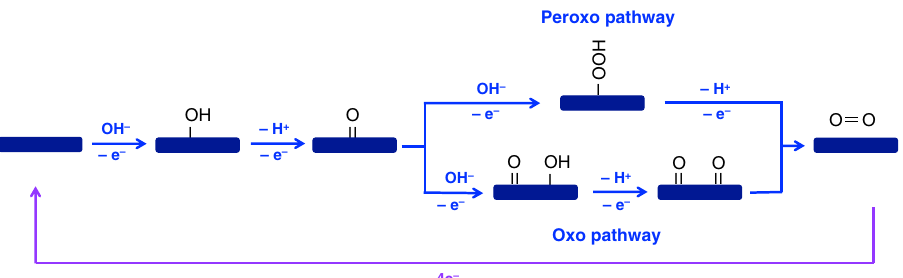
Fig. 1 Schematic illustration of proposed OER mechanisms. Peroxo and oxo pathways for OER mechanisms on a transition-metal oxide/oxyhydroxide/ hydroxide electrode surface in a basic solution are illustrated. The – e − in blue indicates electrons transferred from hydroxide to the catalyst while – e − in purple indicates electrons transferred from the catalyst to the back contact and eventually to the